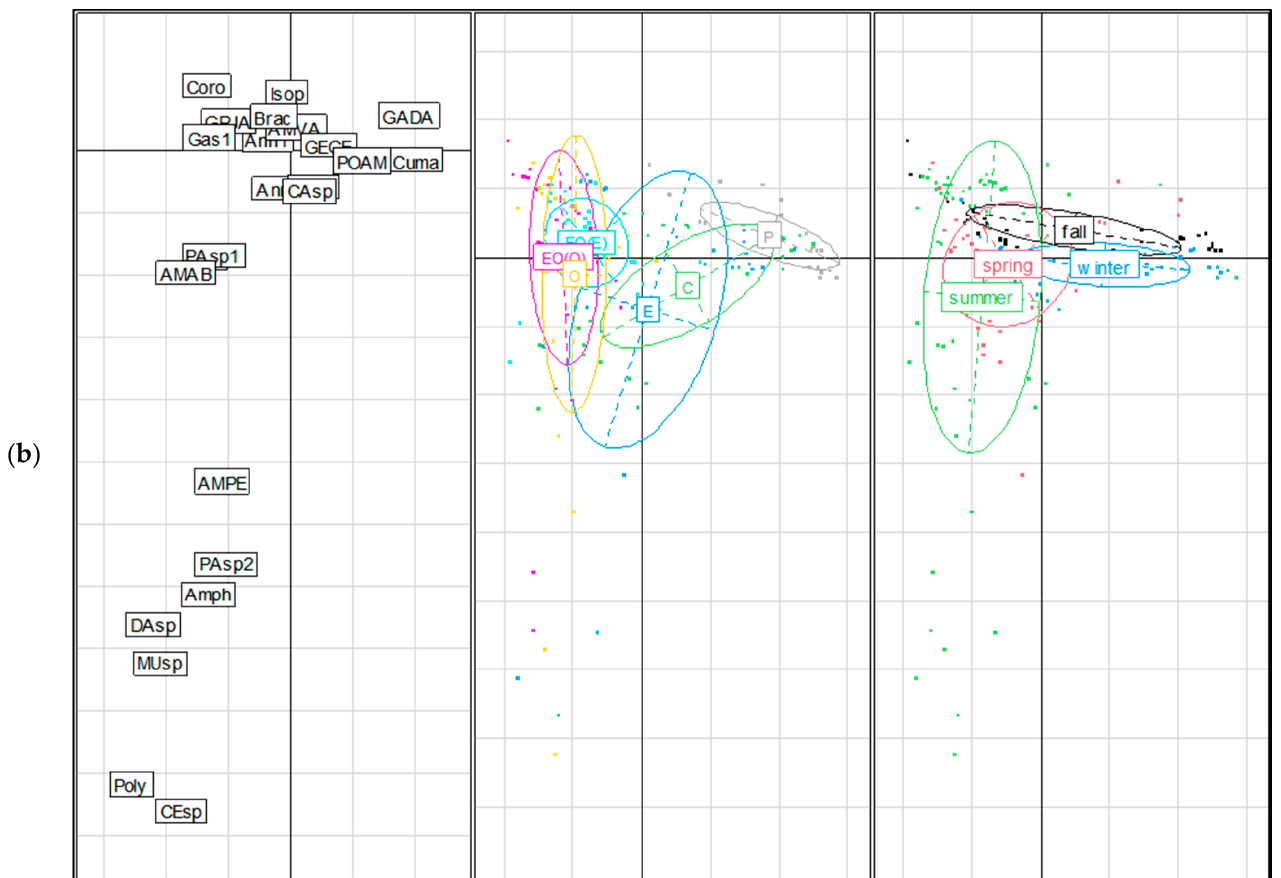
Figure 2. ( a ) Correspondence analysis of taxa detected by suction sampling during pre-treatment (Pre, Oct 2011–July 2012) and first year after treatment (July 2013–April 2014); and ( b ) Correspondence analysis of taxa detected by suction sampling during pre-treatment (Pre, Oct 2011–July 2012) and first year after treatment (July 2013–April 2014), second year after treatment (summer only, July 2014), and third year after treatment (summer only, July 2015). Panels show taxa ( left ) coded by treatment ( center ) and season ( right ), with all taxa. Treatment abbreviations as in previous figures, taxa abbreviations detailed in Appendix A Tables A1 and A2. Correspondence Analysis (ade4) Factors 1 and 2: ( a ) Inertia = 38.18%; and ( b ) Inertia = 28.19%.